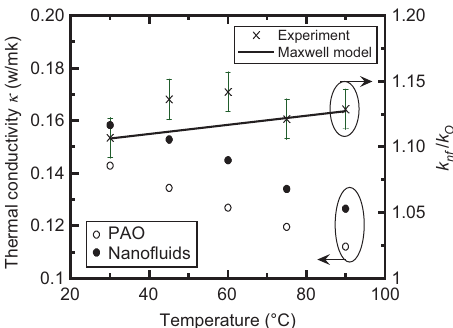
Figure 16 The thermal conductivity of the pure PAO and the indium in the PAO nanofluid (left x-axis) and the relative conductivity of the nanofluid (right x-axis) vs. temperature. The relative thermal conductivity estimated from the Maxwell model (solid line) is also shown for comparison. A temperature-independent interfacial resis-